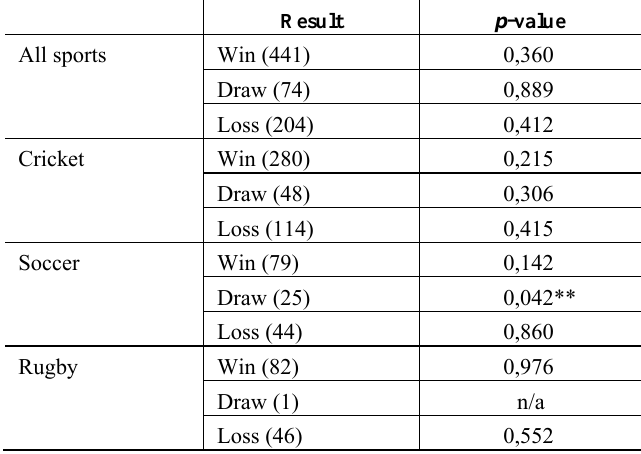
Table 4: Summary statistics of the dummy-variable regression